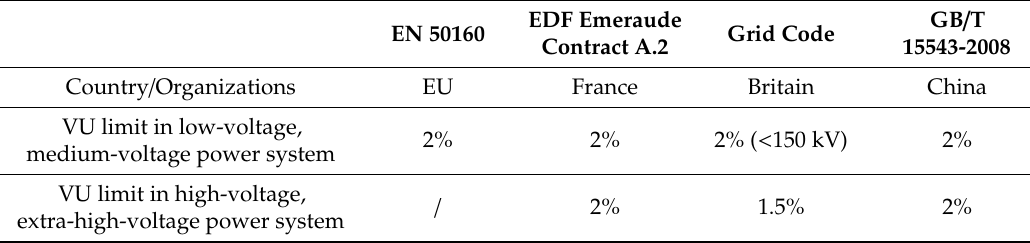
Table 1. The comparison of voltage unbalance (VU) limits between the various countries.